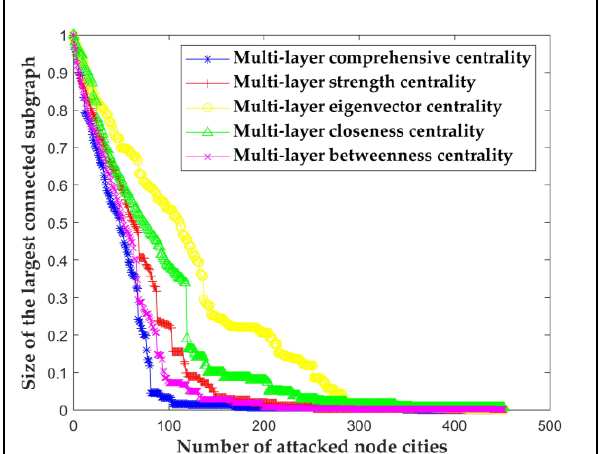
Figure 11. Attack results of different multi-layer centrality.